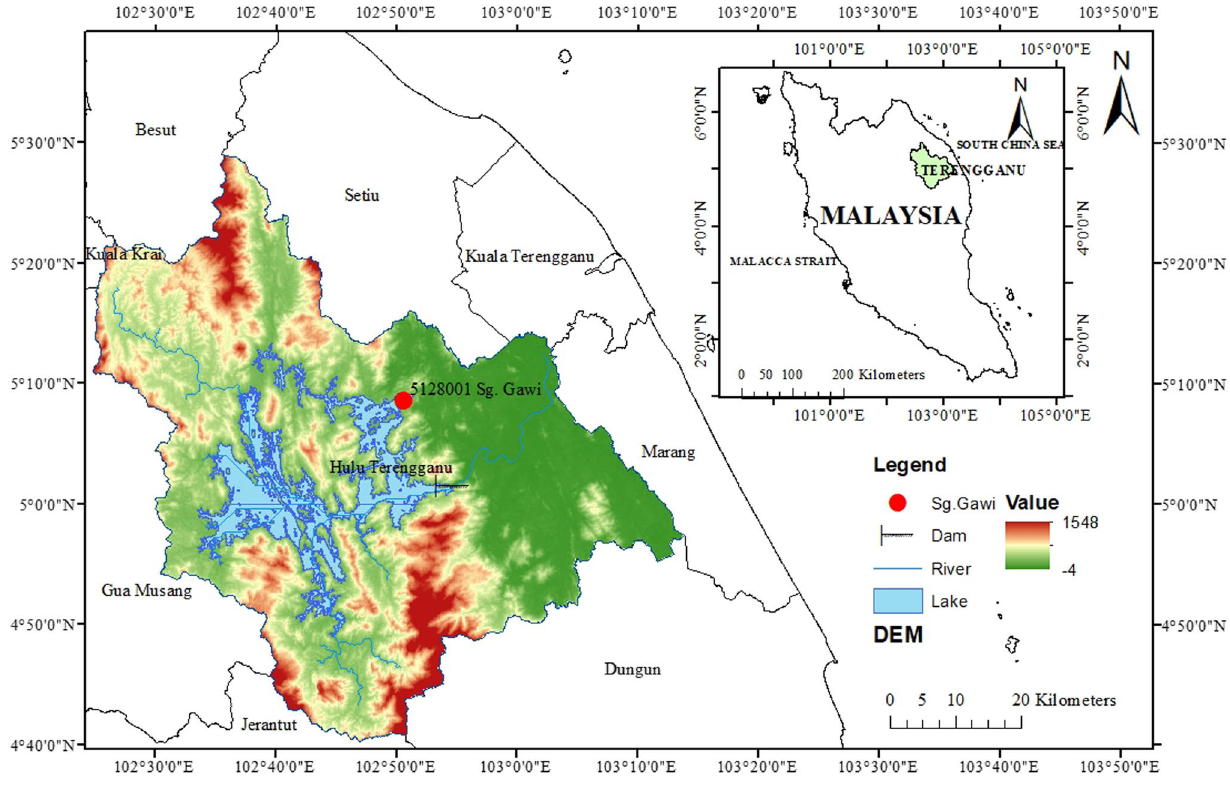
Fig. 1 Location of Study